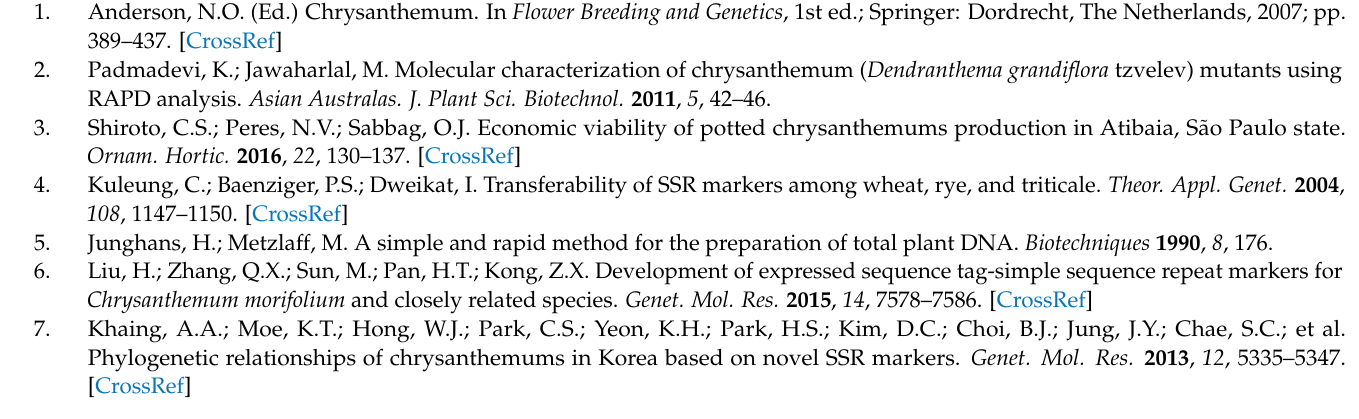
Table S3: Nei Genetic Distance, Table S4: Parameters for identifying the true K value, Table S5A: Admixture proportions for K = 3, Table S5B: Admixture proportions for K = 4, Table S5C: Admixture proportions for K =